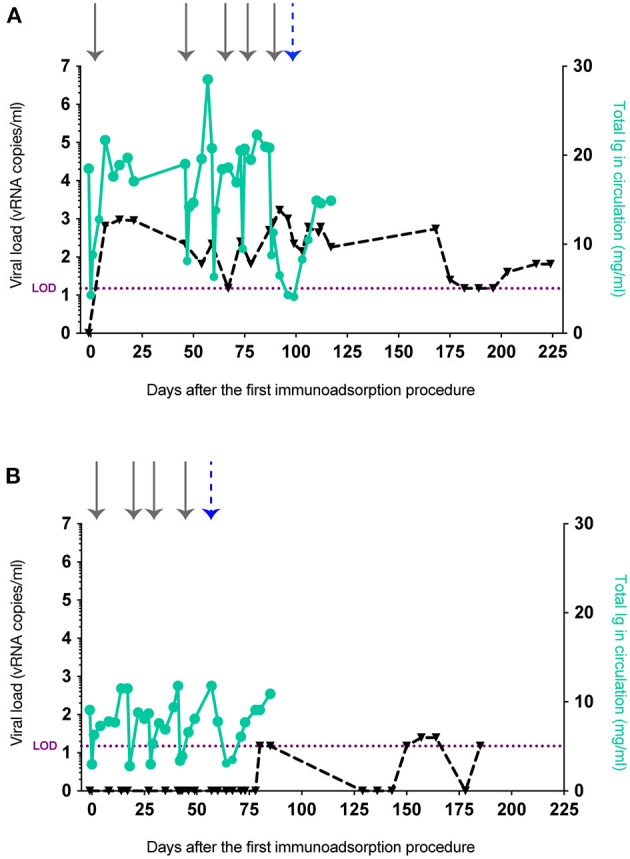
IgG levels and viral loads after the removal of circulating Abs from r05007 and r09062. Ig depletion by immunoadsorption and anti-FcRn Ab infusion of (A) r05007 and (B) r09062. Gray arrows indicate each immunoadsorption procedure. The blue dashed arrow indicates the first anti-FcRn Ab infusion. Viral load limit of detection (LOD) is shown as purple dotted line.